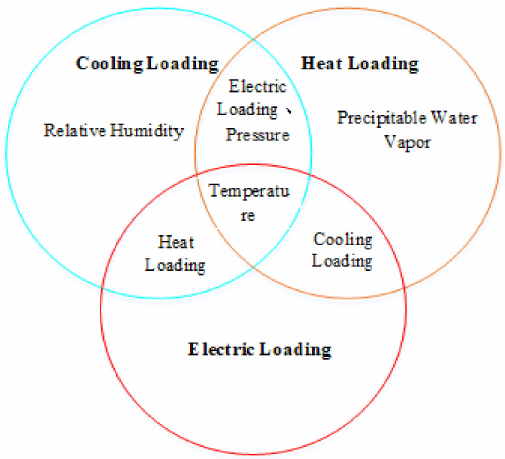
Figure 10. Main influencing factors between multivariate